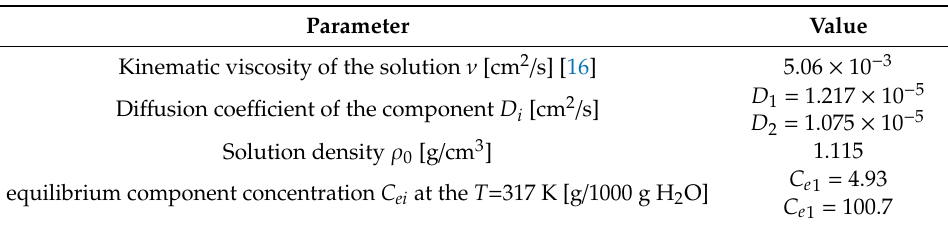
Table 1. Hydrodynamic model parameters.